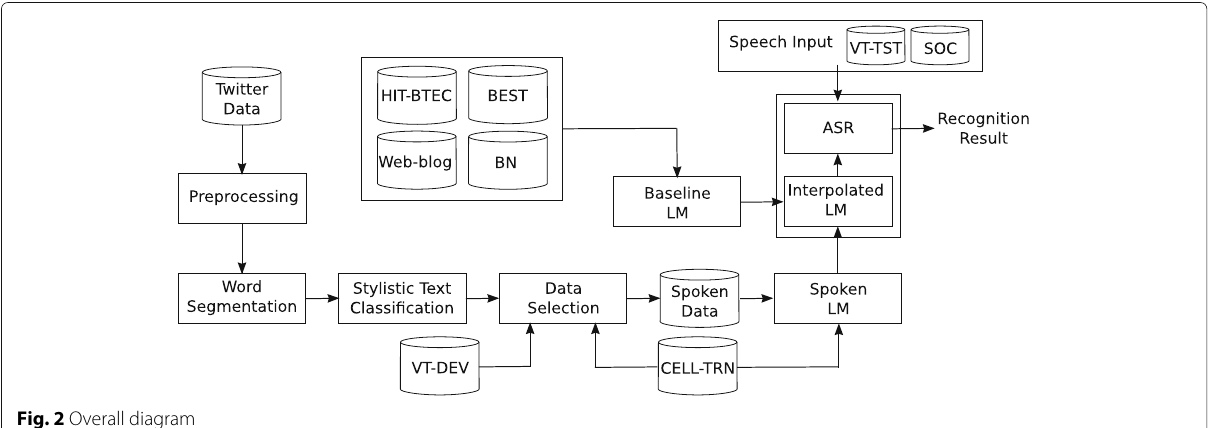
Fig. 2 Overall diagram